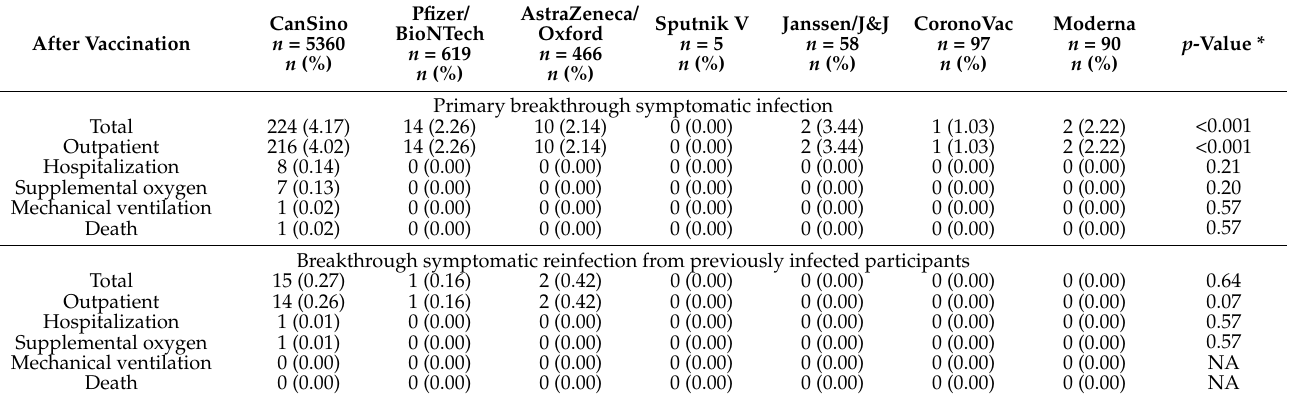
Table 1. Clinical characteristics of patients presenting COVID-19 breakthrough infections and reinfections after full vaccination.